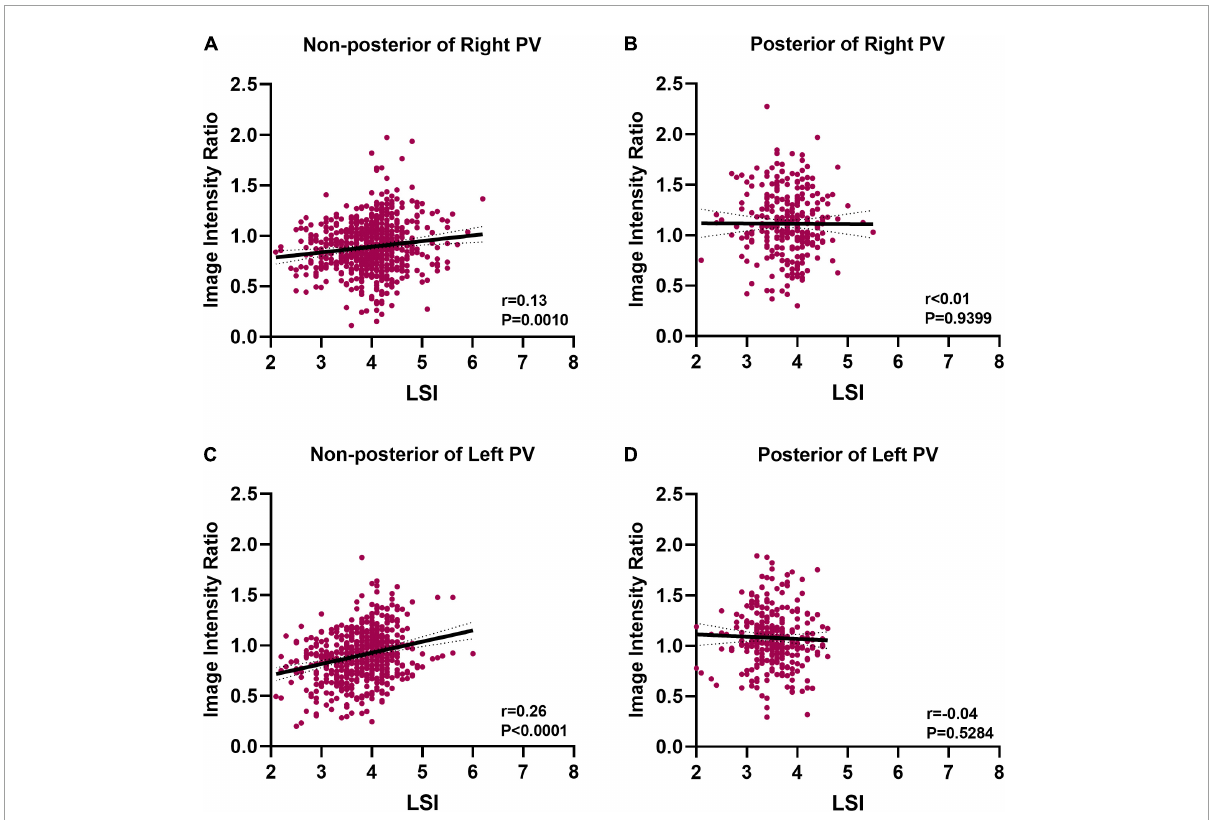
FIGURE7 Correlation between image intensity ratio and LSI. (A) Positive correlation between image intensity ratio and LSI at non-posterior of right PV ( r = 0.13). (B) There was no correlation between image intensity ratio and LSI at posterior of right PV. (C) Positive correlation between image intensity ratio and LSI at non-posterior of left PV ( r = 0.26). (D) There was no correlation between image intensity ratio and LSI at posterior of left